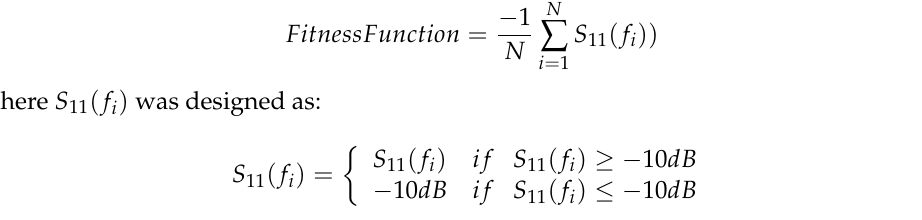
Table 1 organizes and summarizes the genetic algorithm optimization setup.